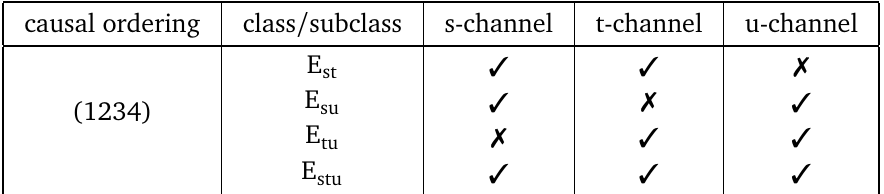
Table 16: OPE convergence properties of type 12 causal